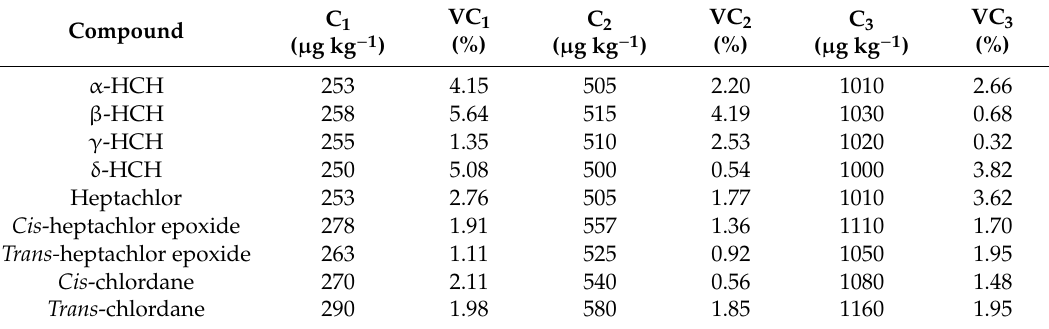
Table 5. Variation coe ffi cients (VC) for nine organochlorines in three concentration levels, 250 (C 1 ), 500 (C 2 ), and 1000 µ g kg − 1 (C 3 ).